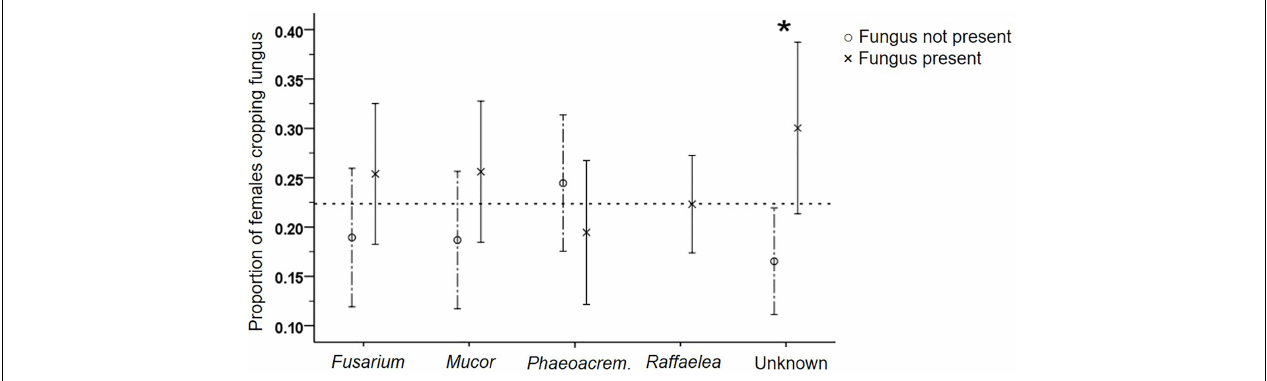
FIGURE 6 | Effect of the presence of the five different fungi on the frequency of adult female fungus cropping . Mean ( ± SE) frequencies, for fungus present or not per gallery, are given. Raffaelea was always present. * p < 0.05 (for exact values see Supplementary Table S7 ).